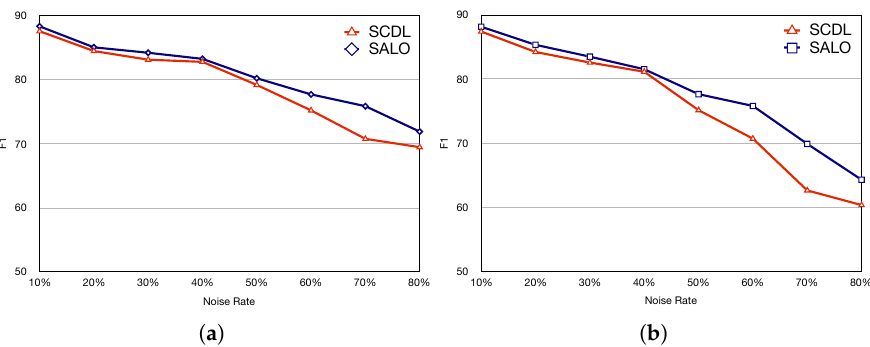
Figure 3. Robustness to different noise ratios of two types of noise. Incomplete noise: tagging some entities to “O” tags and Inaccurate noise: replacing one type entity tag to another entity tag. ( a ) Span noise; ( b ) Category noise.